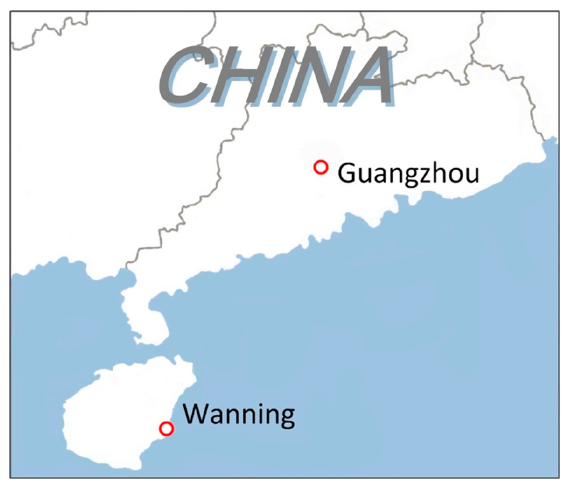
Figure 2. Location of the exposure test site. Table 2. Average environmental data measured in 1997 at Wanning.